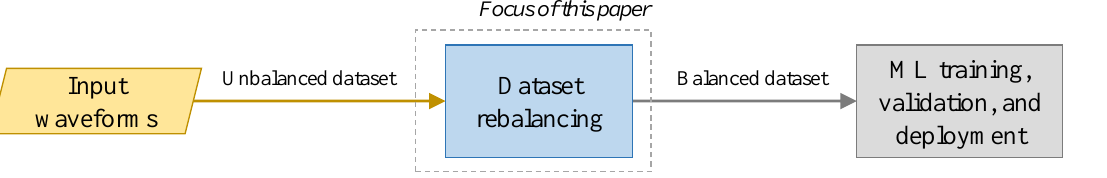
Figure 2. General overview of the work presented in this